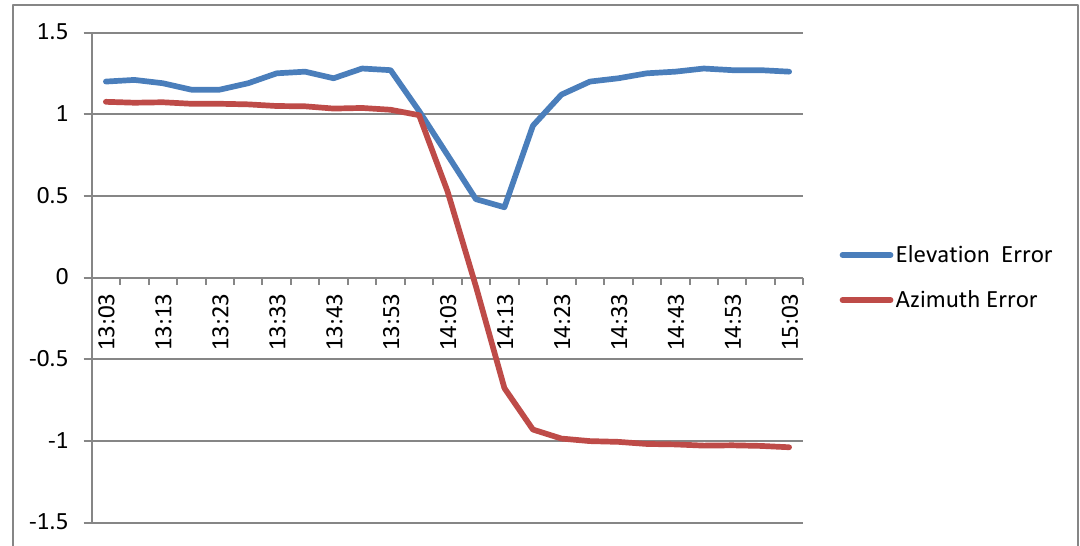
Figure 16. Elevation and azimuth errors inferred by the FRBS.